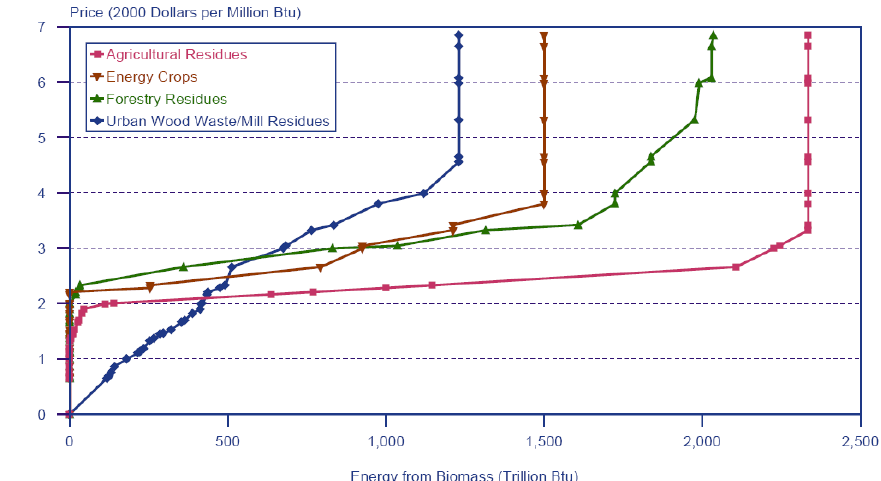
Figure 75. Cost-supply curves for US biomass (after